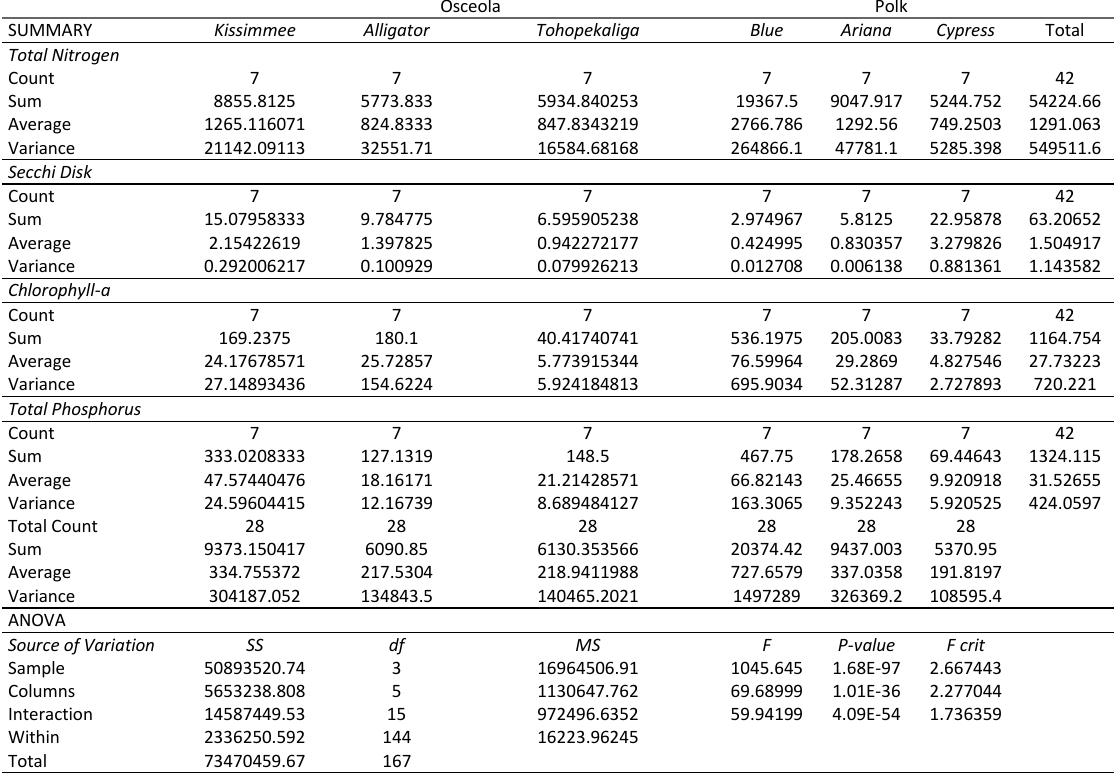
Table 4: ANOVA: Two-Factor with Replication used to compare Osceola and Polk counties (n=168)